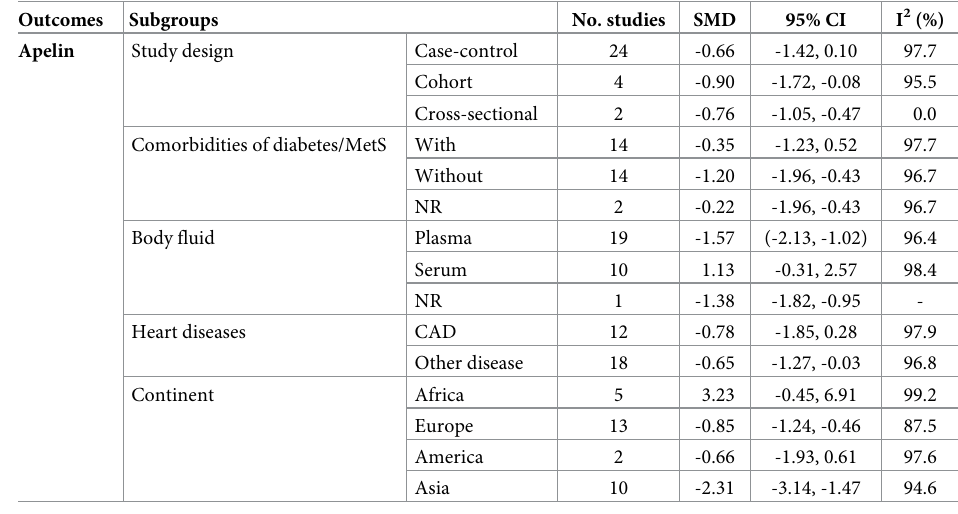
Table 2. Subgroup analyses